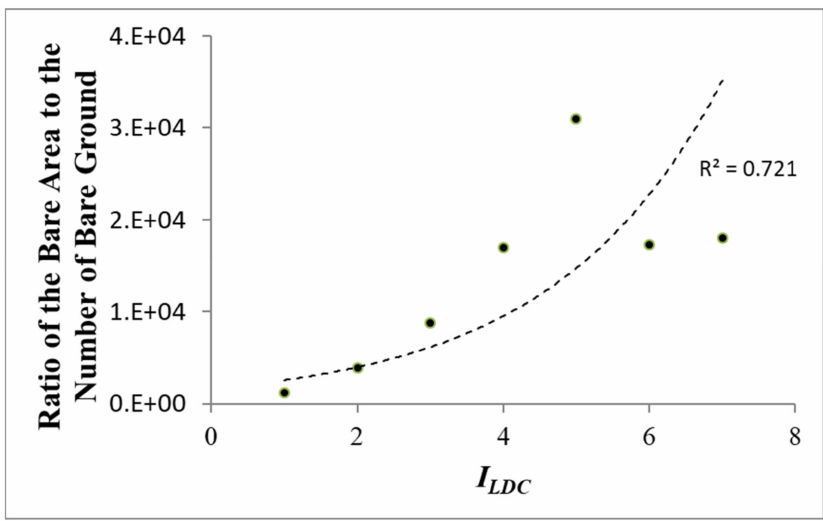
Figure 8. Regression line of the ratio of the bare land area to the number of bare lands against I LDC